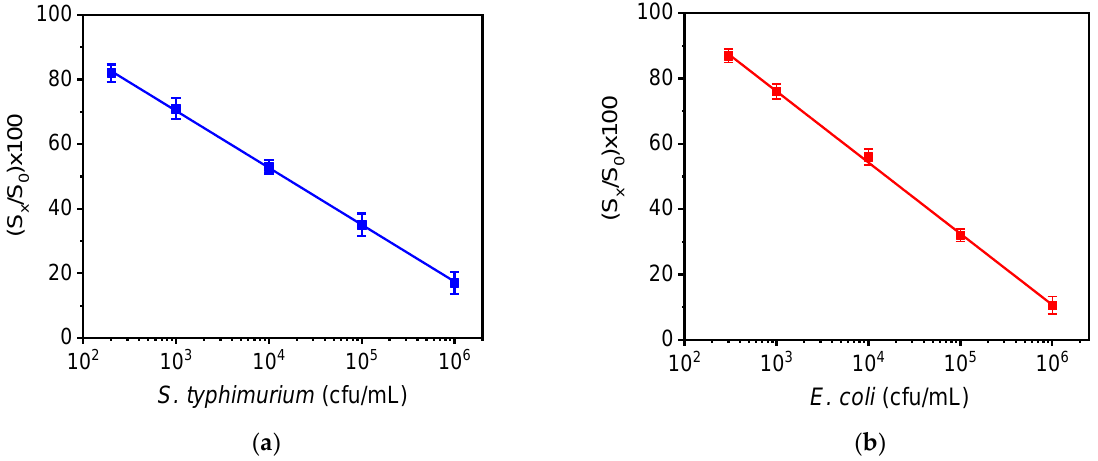
S. typhimurium from 7 chips) and was 40 cfu/mL and 110 cfu/mL for S. typhimurium and E. coli , respectively.